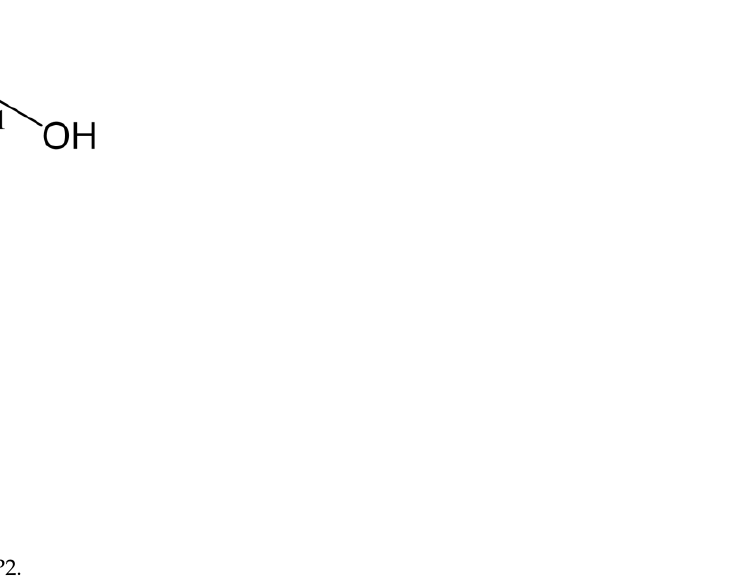
Figure 11. Structure of P2.